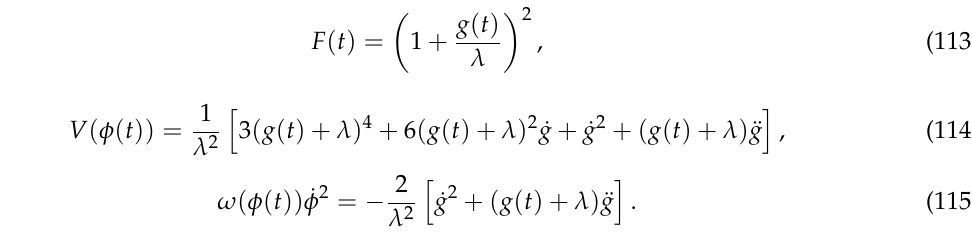
Figure 1. The dependence r = r ( n S ) for different values of the constant µ 2 = 1/2,